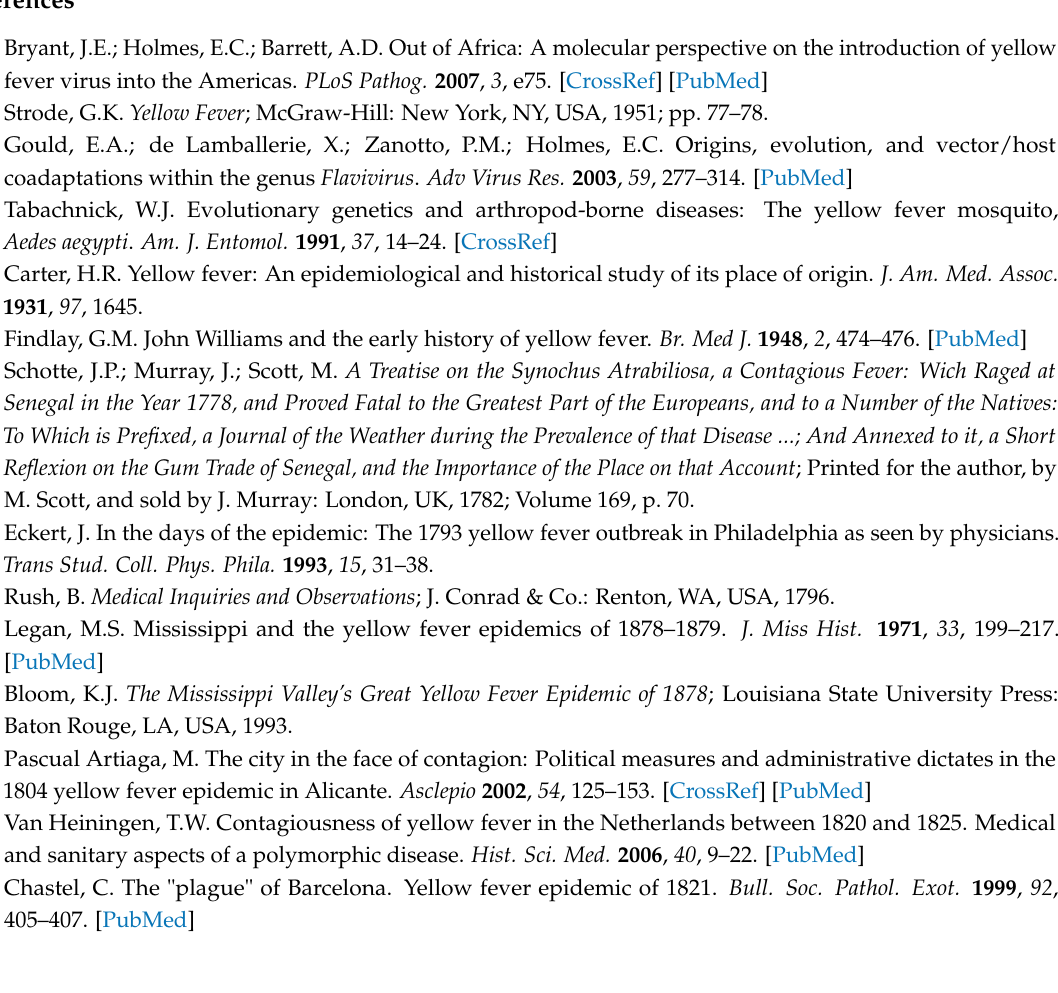
Table S1: Yellow fever virus in